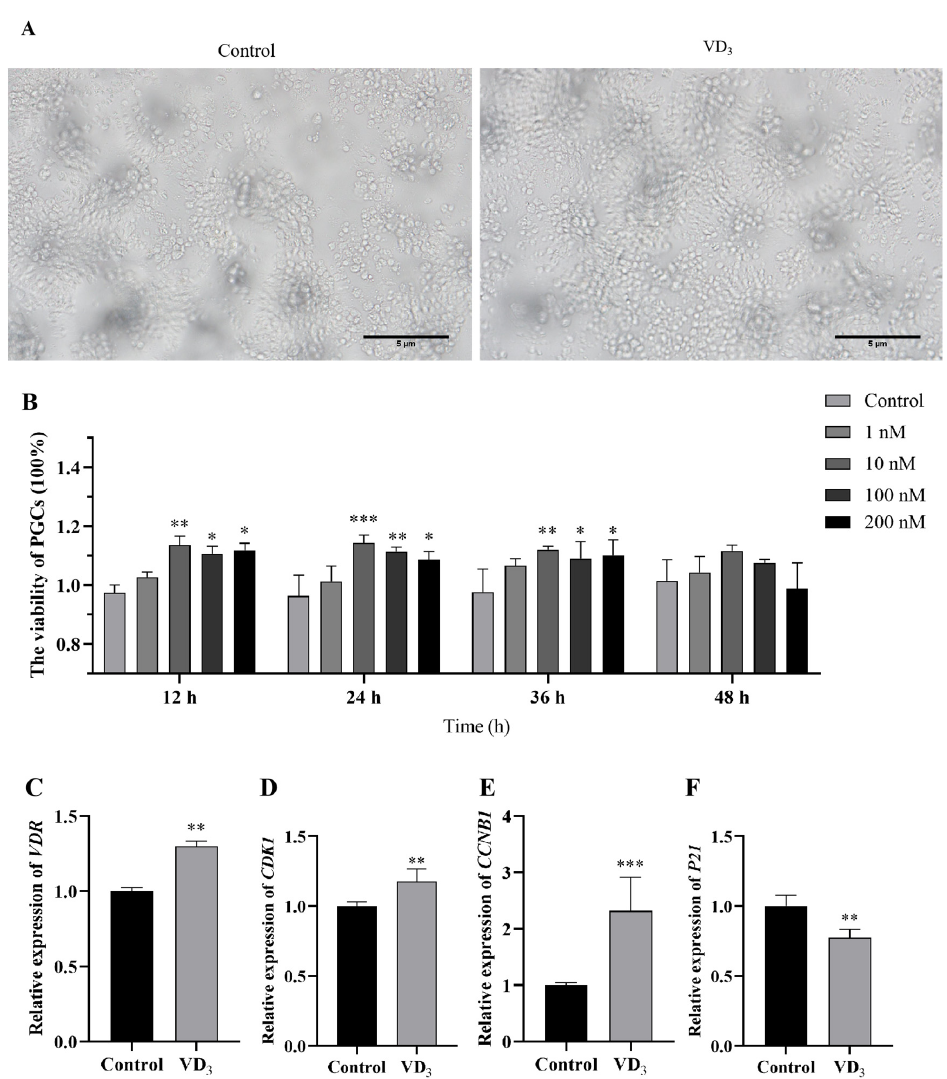
Figure 1. Effects of 1 α ,25(OH) 2 D 3 on PGC viability. ( A ) The proliferation of PGCs under a light microscope after 24 h treatment. ( B ) The relative viability of PGCs treated with the different doses of 1 α ,25(OH) 2 D 3 for different times (two ‐ way ANOVA and post hoc Student’s t test). Relative expression of VDR ( C ), CDK1 ( D ), CCNB1 ( E ), and P21 gene ( F ) in PGCs. Bar = 5 μ m. VD 3 : 1 α ,25(OH) 2 D 3 . Data are means ± SE of three independent replicates (* p < 0.05, ** p < 0.01, *** p < 0.001).